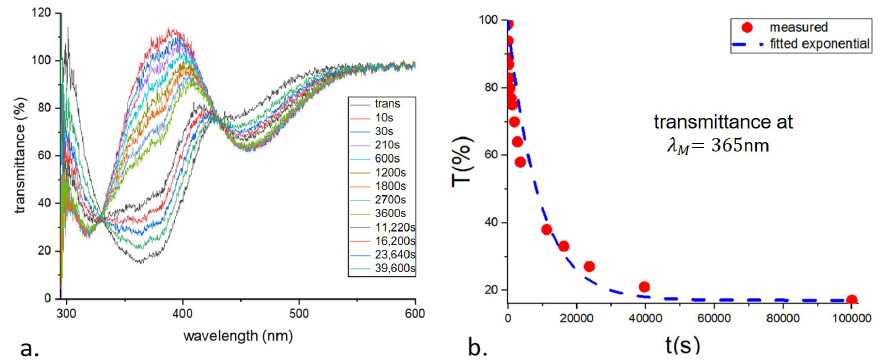
Figure 3. ( a ) Transmittance of the sample as a function of time. The normalization is against that of an undyed LCE sample with the same constituents except the azo acrylate. The curve with the lowest transmittance, around 365 nm, corresponds to the sample with all the dye molecules in the trans- state. ( b ) Transmittance at 365 nm as a function of time.